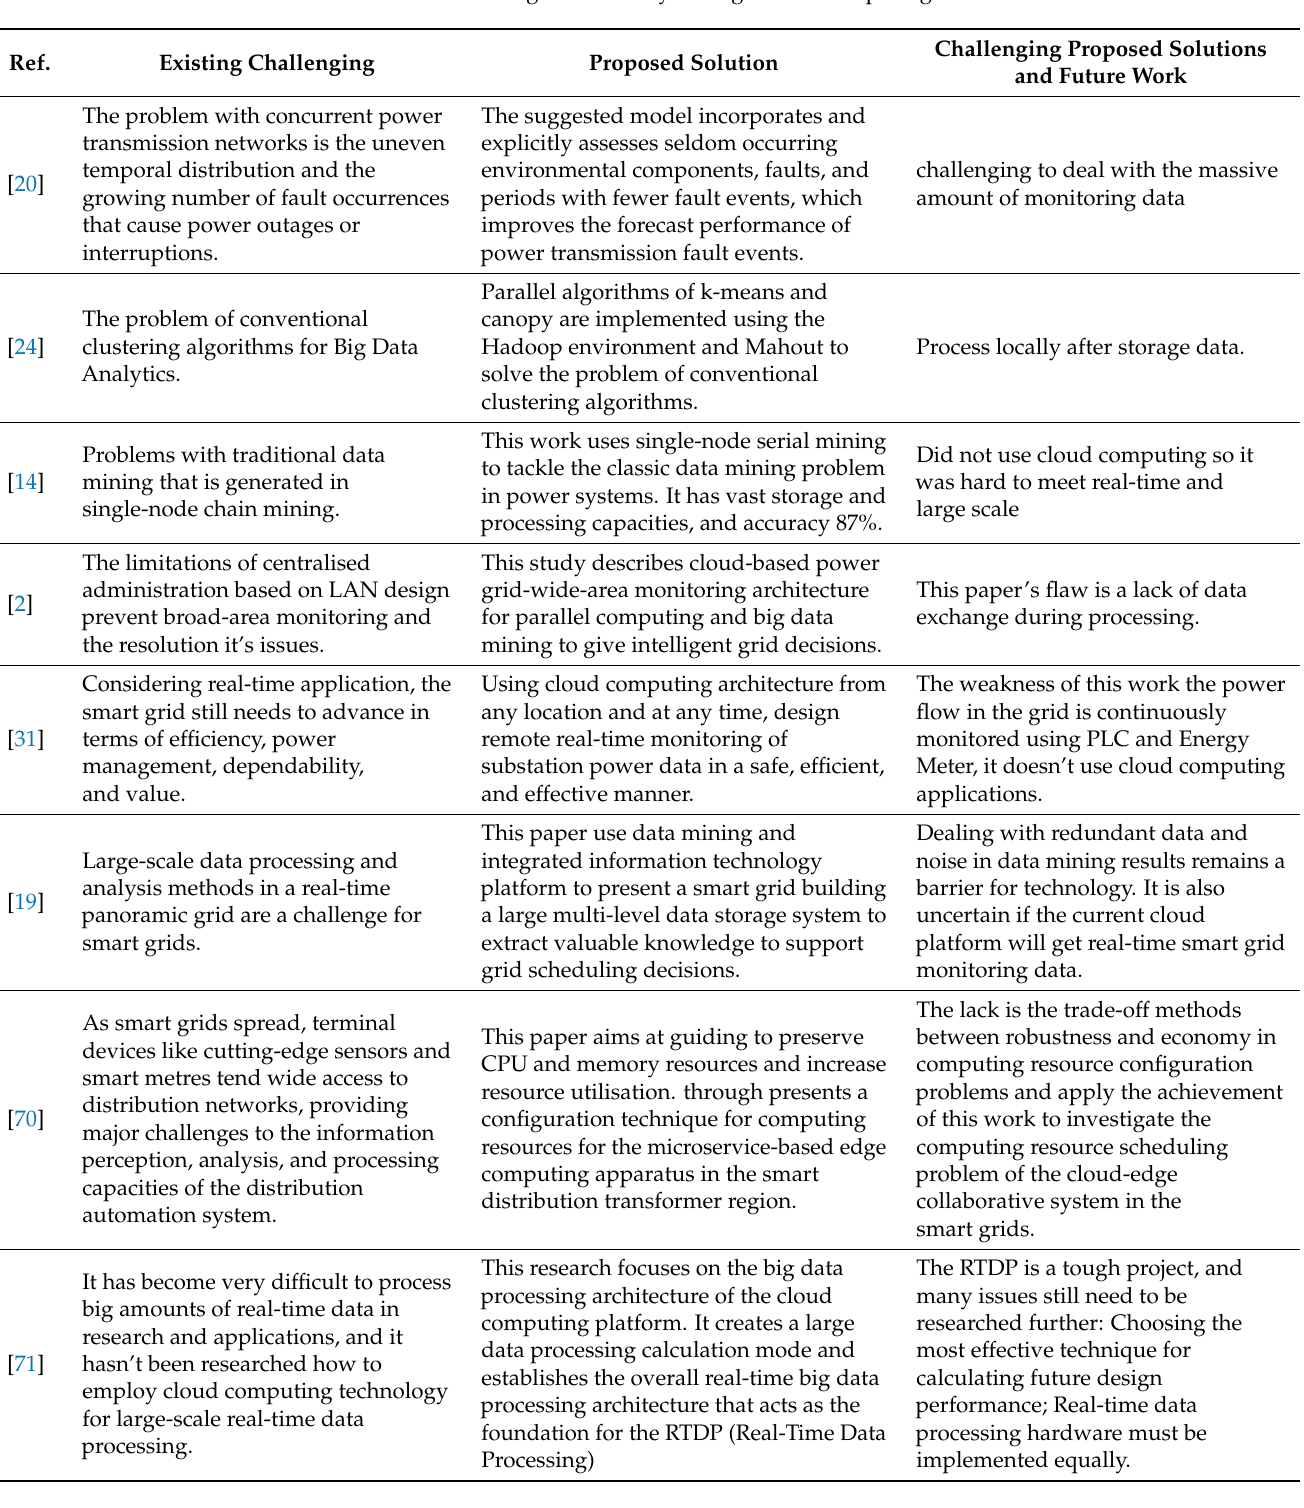
Table 1. The difficulties managing information and data due to the millions of intelligent meters data that need to be managed effectively through cloud